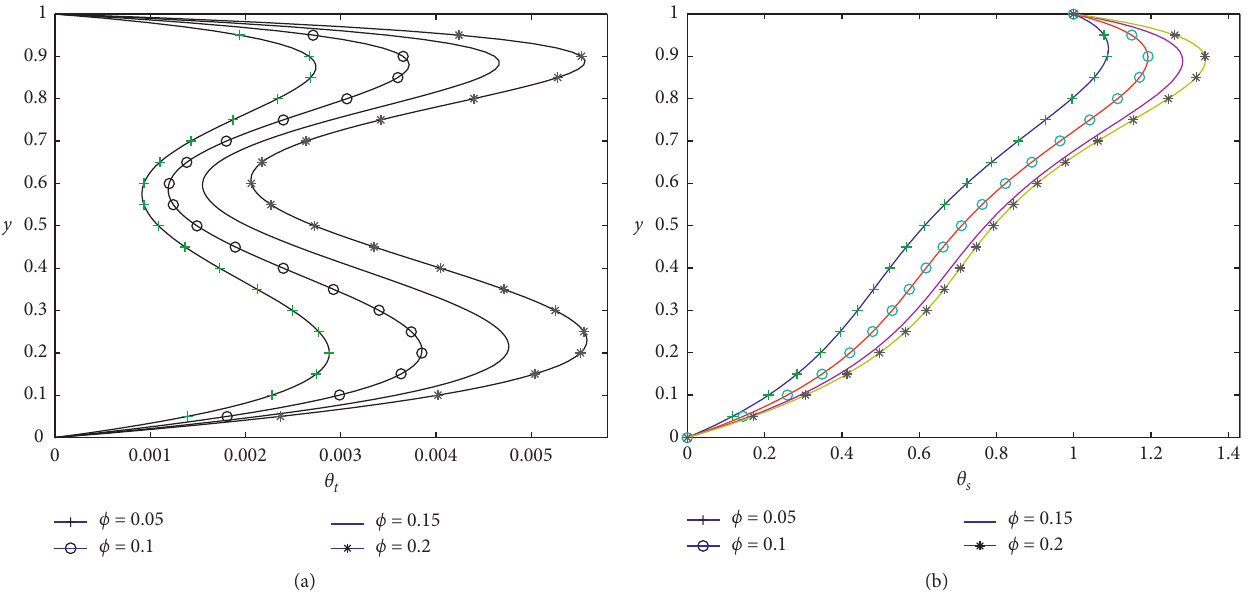
Figure 6: Effect of ϕ on (a) unsteady and (b) steady temperature distributions when t � π /4 , ε � 0 . 01 , H � 3 , β � 2 , Ec � 1 , Q � 0 . 5 , Da